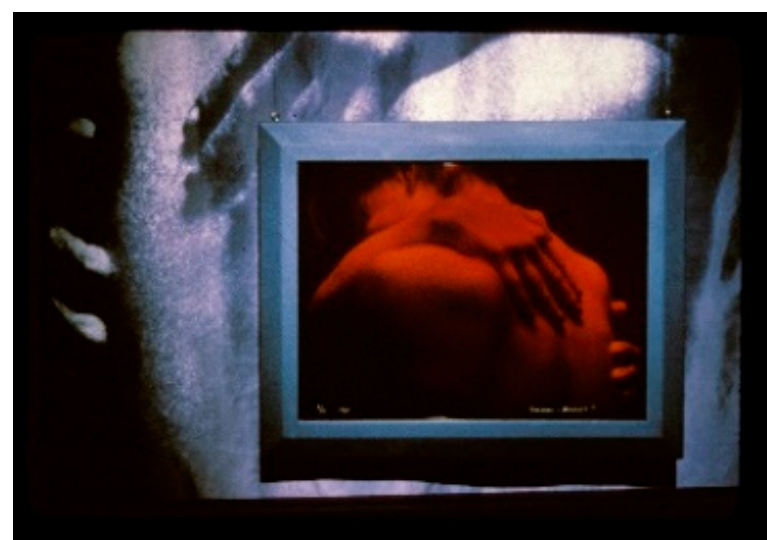
Figure 8. Suspended hologram in front of a banner created by Crenshaw & Dinsmore. Arts 2019 , 8 , x FOR PEER REVIEW